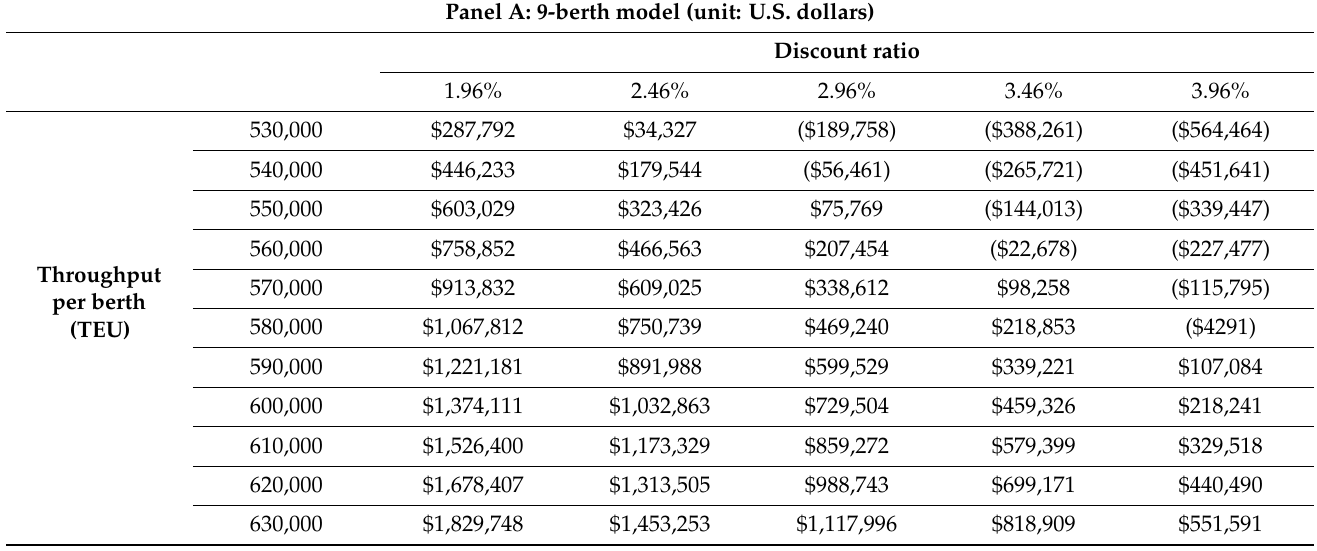
Table A1. NPV per berth considering changes of processing quantity and discount ratio. Panel A: 9-berth model (unit: U.S.